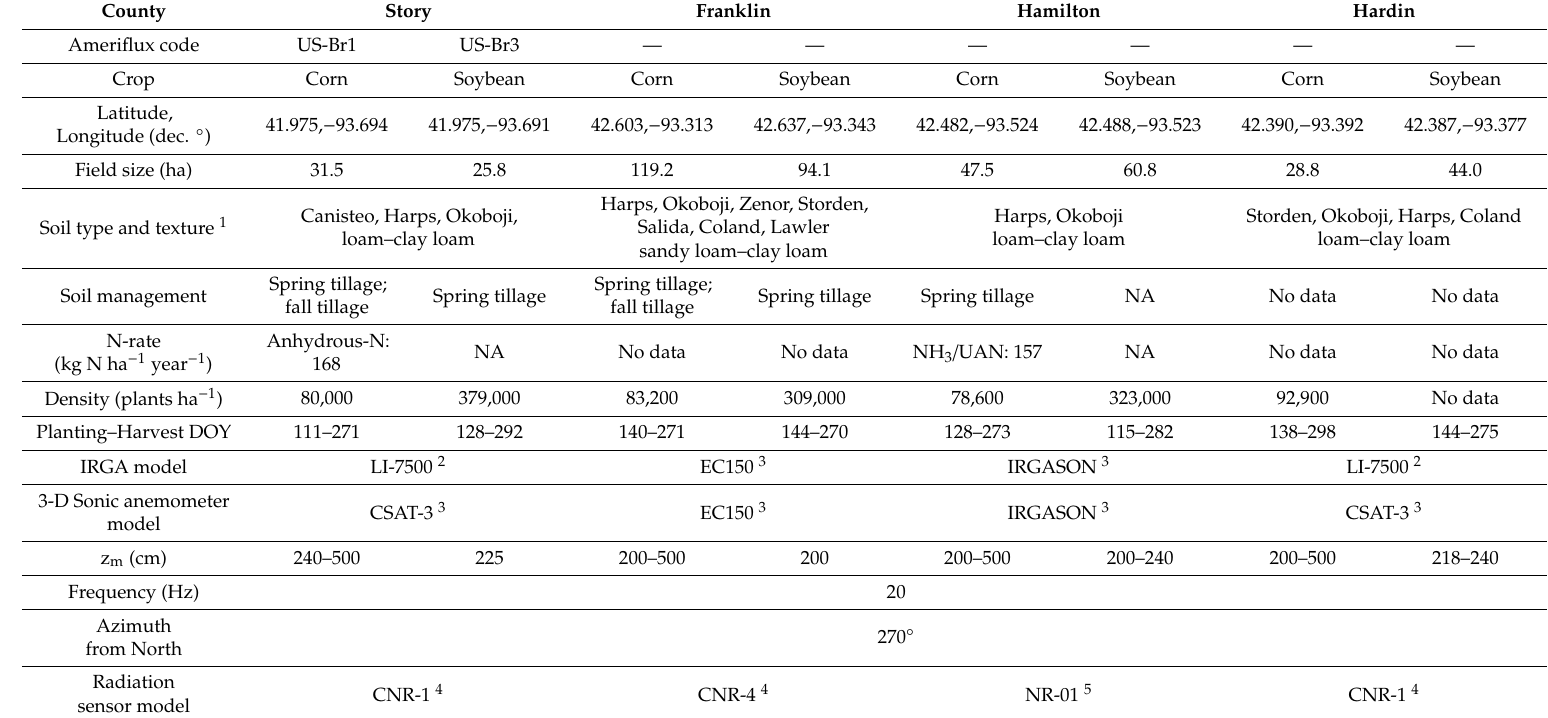
Table 1. Site specifics (location, soils, crop management) and EC station instrumentation (sonic, IRGA, and radiation specifics, measurement height, measurement frequency, and sonic